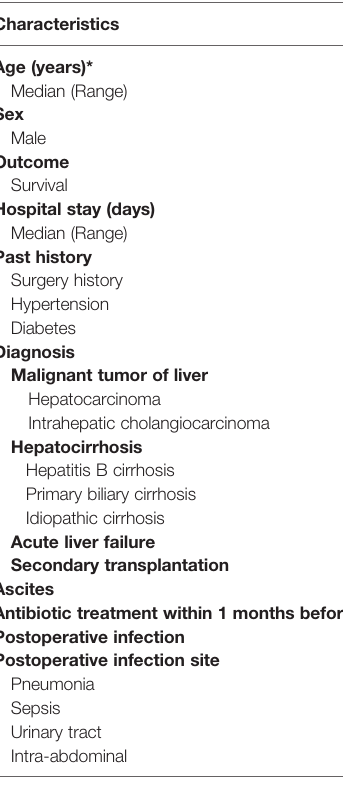
TABLE 1 | Recipient characteristics (N = 42).